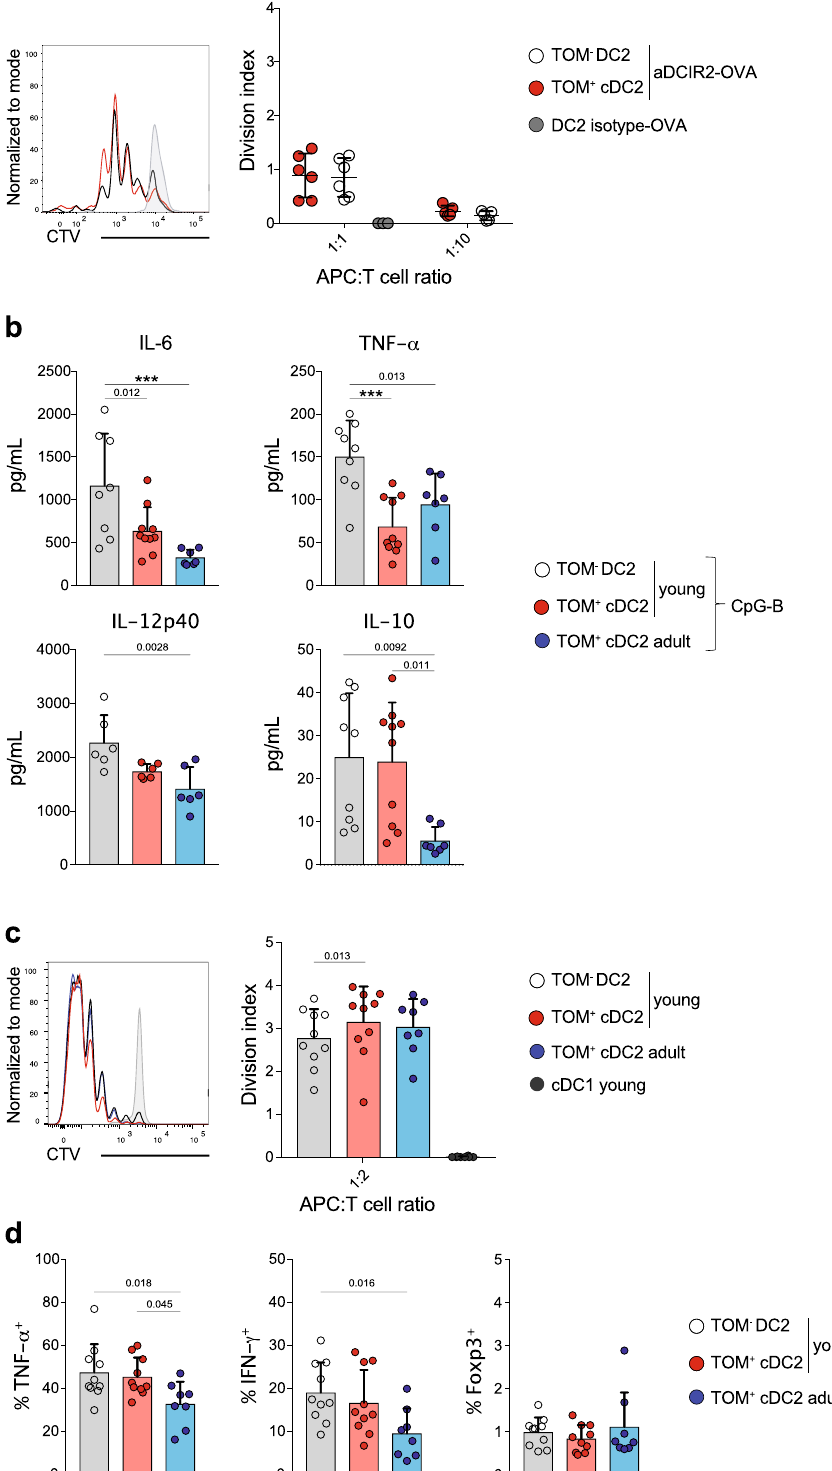
assay, TOM + cDC2 and TOM − DC2 from young mice and cDC2 from adult mice induced similar OT-II T-cell proliferation (Fig. 6c). Targeting was cell-type speci fi c as cDC1 did not promote T-cell proliferation (Fig. 6c). Importantly, T cells stimulated with TOM + cDC2 and TOM − DC2 from young mice produced more TNF- α than T cells stimulated with cDC2 from adult mice (Fig. 6d). Notably, this is in contrast to splenic